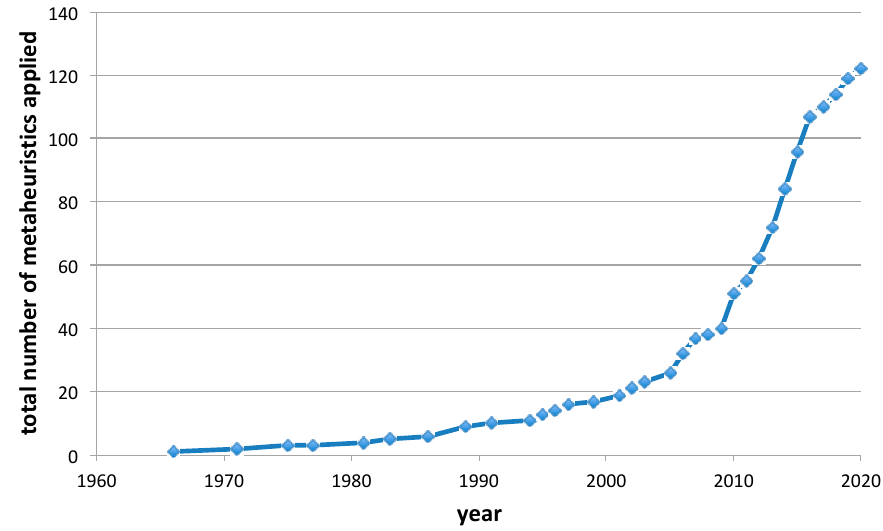
Figure 1. Number of metaheuristics available (variants and hybrid versions excluded).